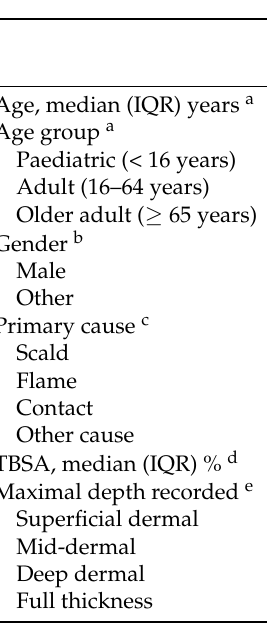
Table 1. Demographic and injury characteristics of overall